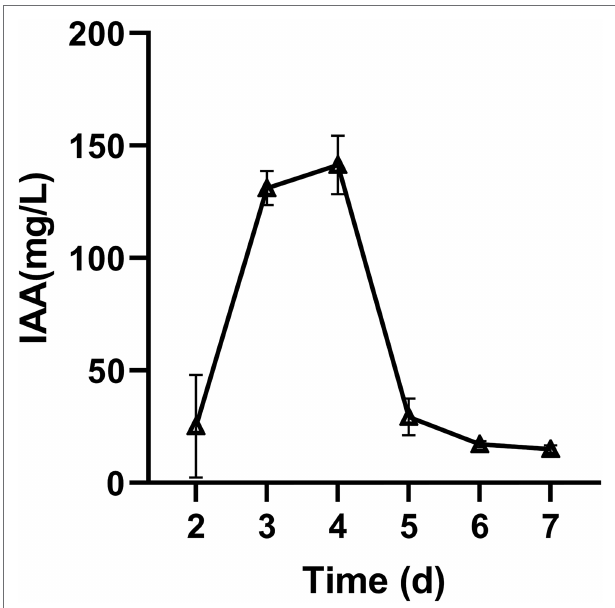
FIGURE 1 | Effects of incubation time on the production of IAA by Mortierella alpina